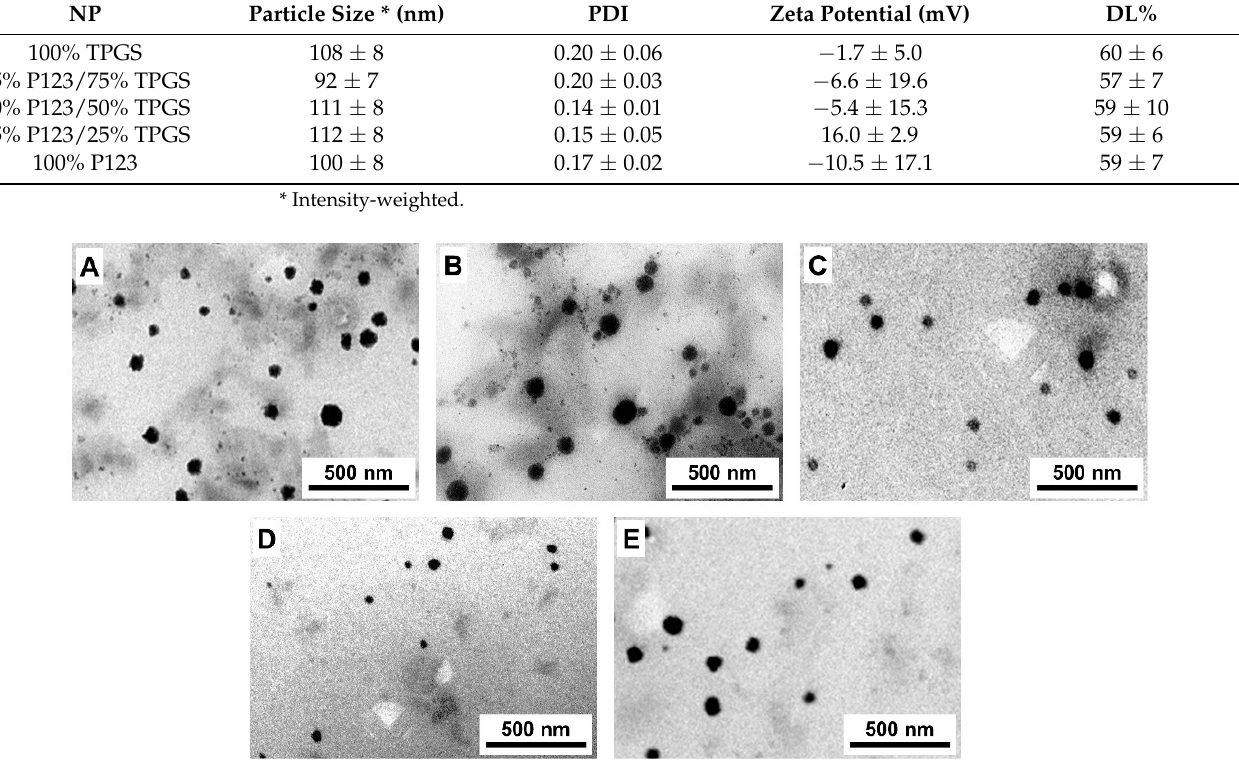
Figure 3. TEM images of R19-loaded NPs prepared using ( A ) 100% TPGS, ( B ) 25% P123/75% TPGS, ( C ) 50% P123/50% TPGS, ( D ) 75% P123/25% TPGS, and ( E ) 100% P123. ( C ) 50% P123/50% TPGS, ( D ) 75% P123/25% TPGS, and ( E ) 100%